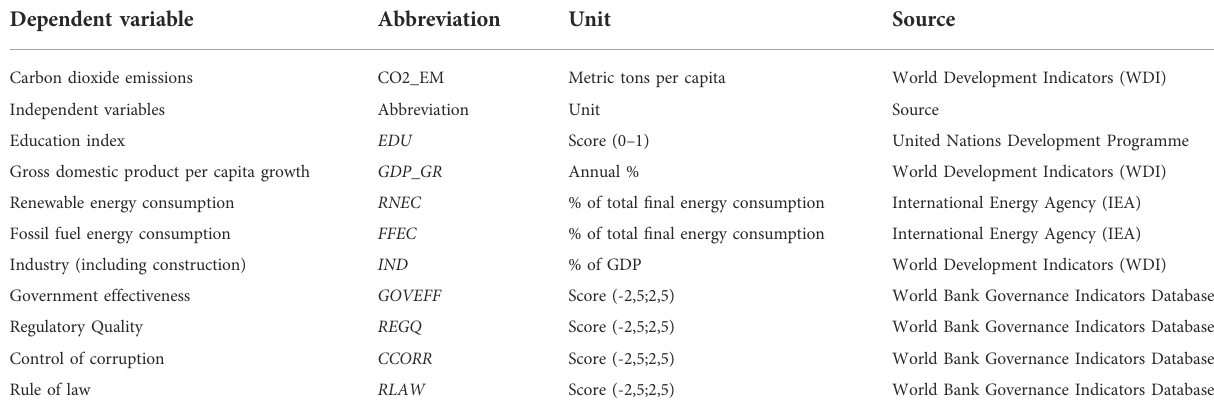
TABLE 1 The variables.